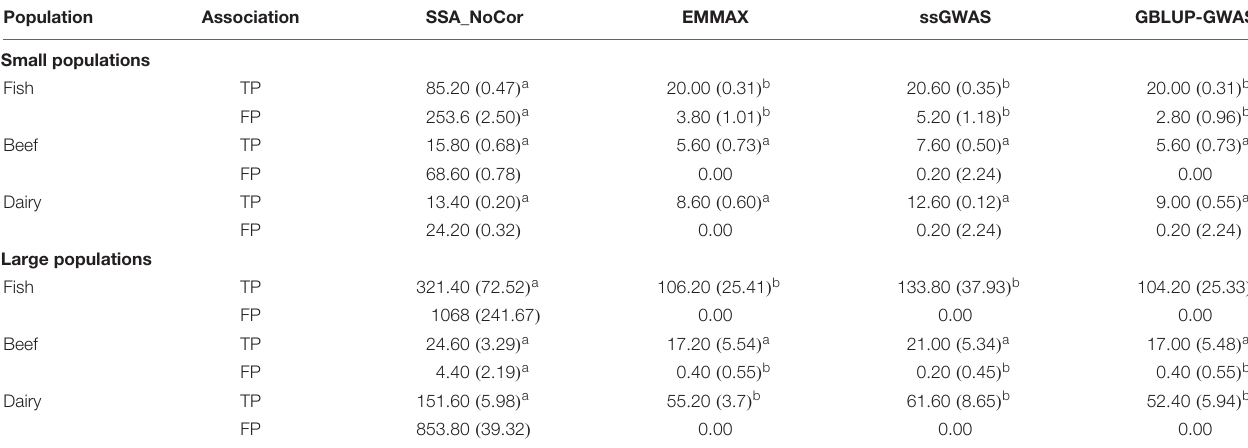
TABLE 2 | Average (SD) number of true positive (TP) and false positive (FP) SNPs for all the simulated populations 1 . Population Association SSA_NoCor EMMAX ssGWAS GBLUP-GWAS